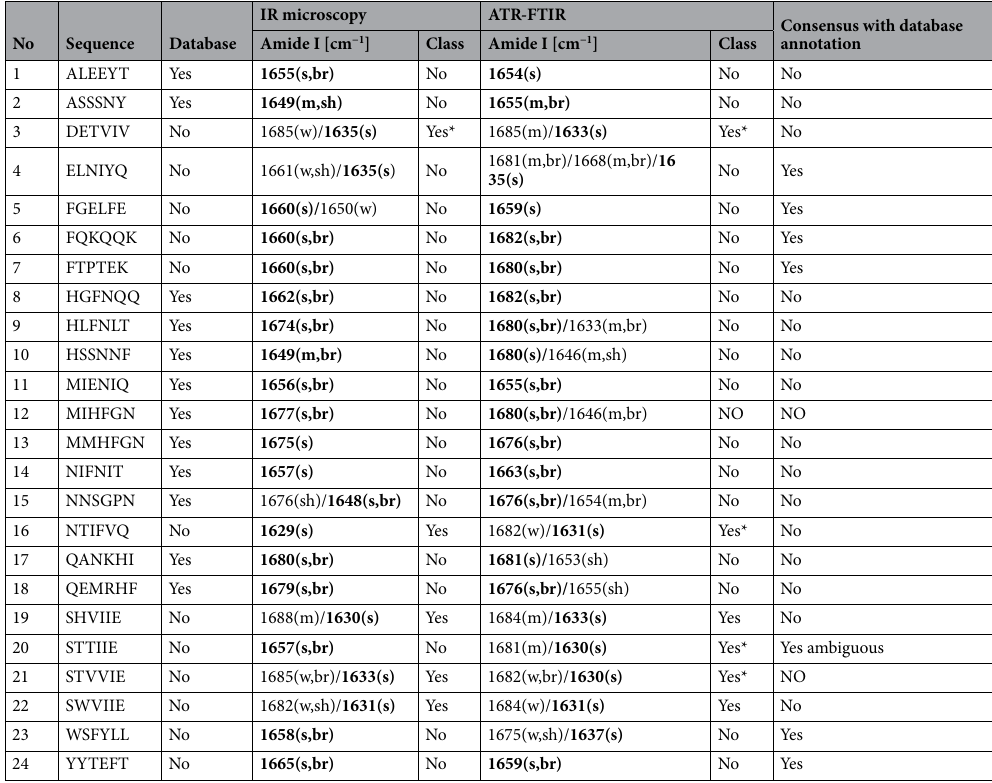
Table 3. Test sequences and their amyloid propensities (’Yes’—identified as amyloid, ’No’—non-amyloid, ’Yes*’—oligomer, ’s’—strong band, ’m’—medium band, ’w’—weak band, ’br’—broad band, ’sh’—shoulder band, band maxima in bold), compared with the original database annotation (all in disagreement with AmyloGram